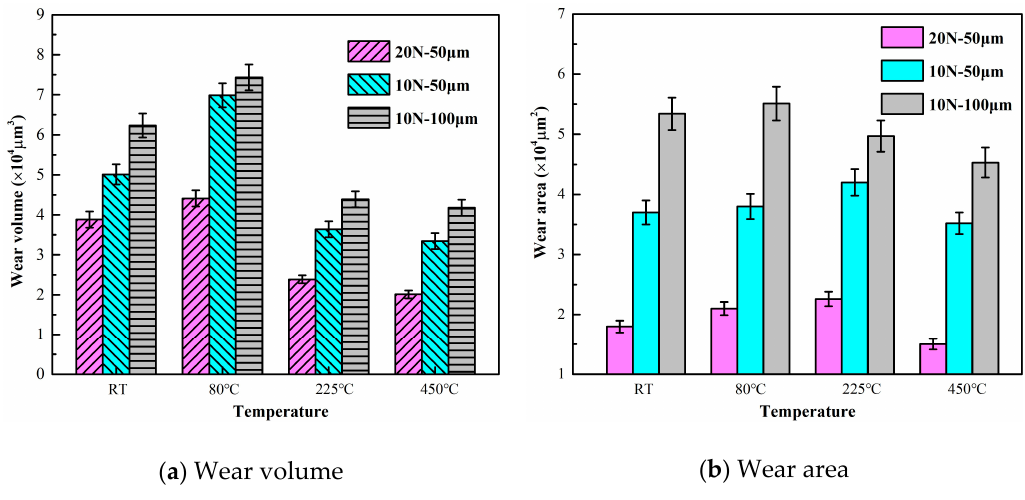
Figure 6. Wear volume and wear area of 2.25 Cr-1Mo steel.